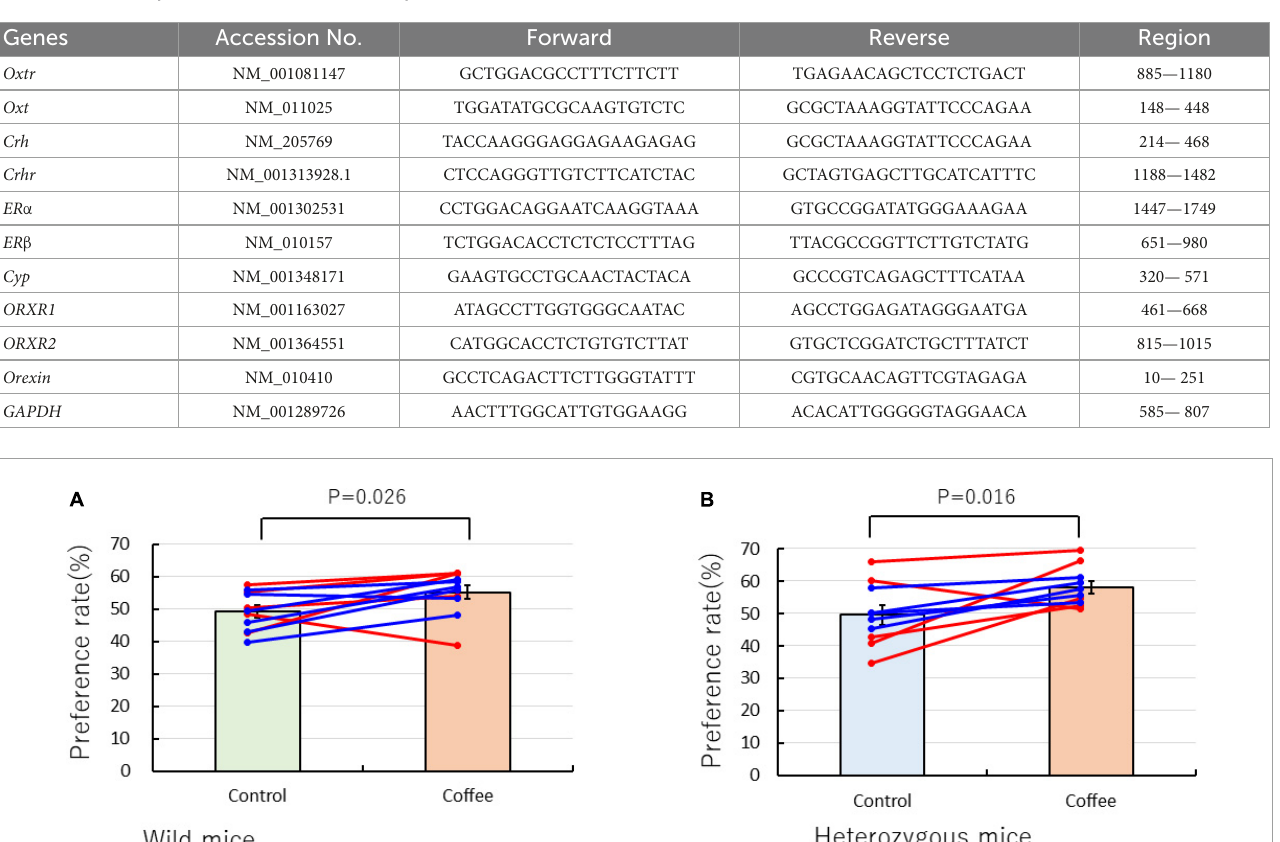
TABLE 1 Primer sequences used for RT-PCR and quantitative PCR.